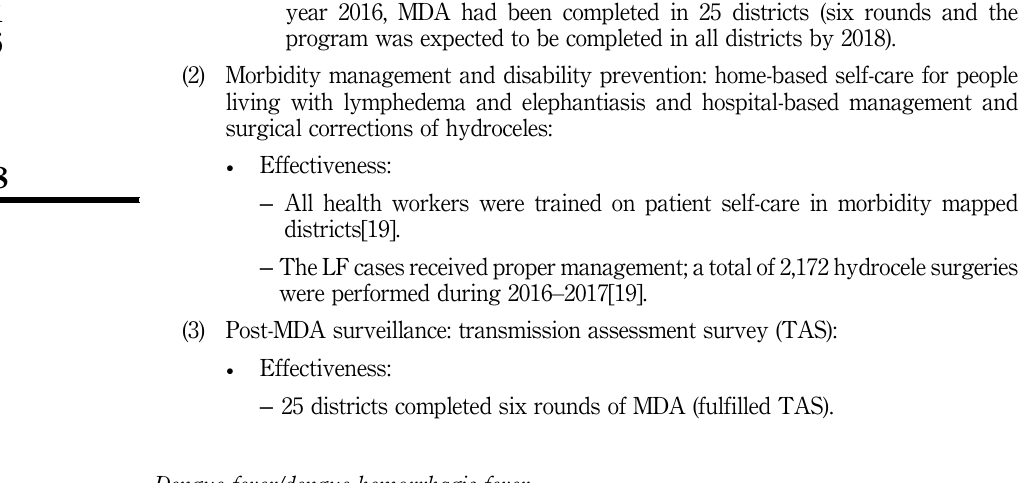
The target of dengue fever/dengue hemorrhagic fever is the reduction of disease burden focusing on the reduction of disease mortality by at least 50 percent in 2020 and reduction of disease morbidity by at least 25 percent in 2020[21]. Control strategies and effectiveness . The effective strategies to control the disease involved early diagnosis and prompt management of the cases and vector control. The strategies implemented to control dengue fever/dengue hemorrhagic fever during 2007 – 2016 were as follows. Strategy I: early case detection, diagnosis, management and reporting of dengue